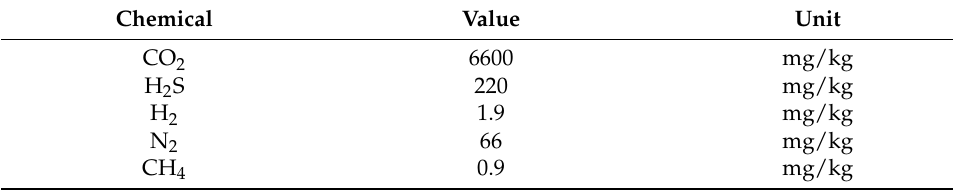
Figure 3. The coupons being removed from the pressure vessel at Reykjanes power plant where they were exposed. Table 3. Gas concentrations in the pressure vessel at Reykjanes power plant